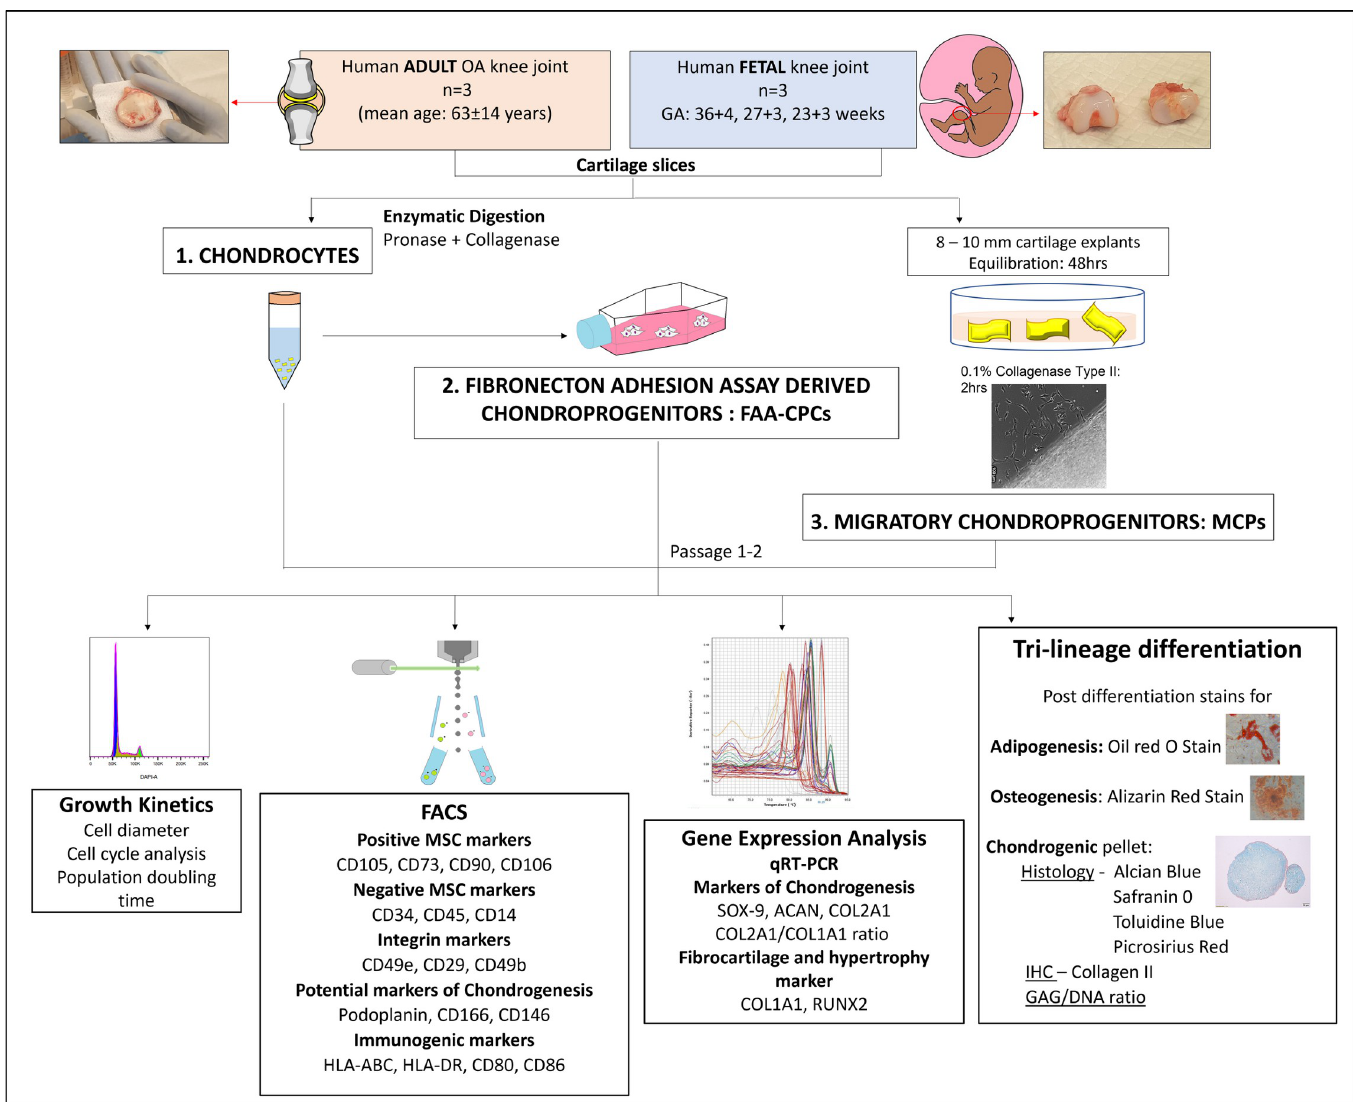
Fig 1. Study algorithm depicting the six groups used for comparison and their evaluation parameters. The six groups included were adult and fetal cartilage derived chondrocytes, fibronectin adhesion assay-derived chondroprogenitors (FAA-CPCs) and migratory chondroprogenitors (MCPs). OA: Osteoarthritis, CD: Cluster of differentiation, SOX-9: (Sex-determining region Y)-box 9, ACAN: Aggrecan, COL: Collagen, RUNX2: Runt-related transcription factor-2, MMP-13: Matrix metalloproteinase-13, GAG: Glycosaminoglycans. All experiments were performed with three biological samples (n = 3). The included figure is similar but not identical to the original image and is for illustrative purposes